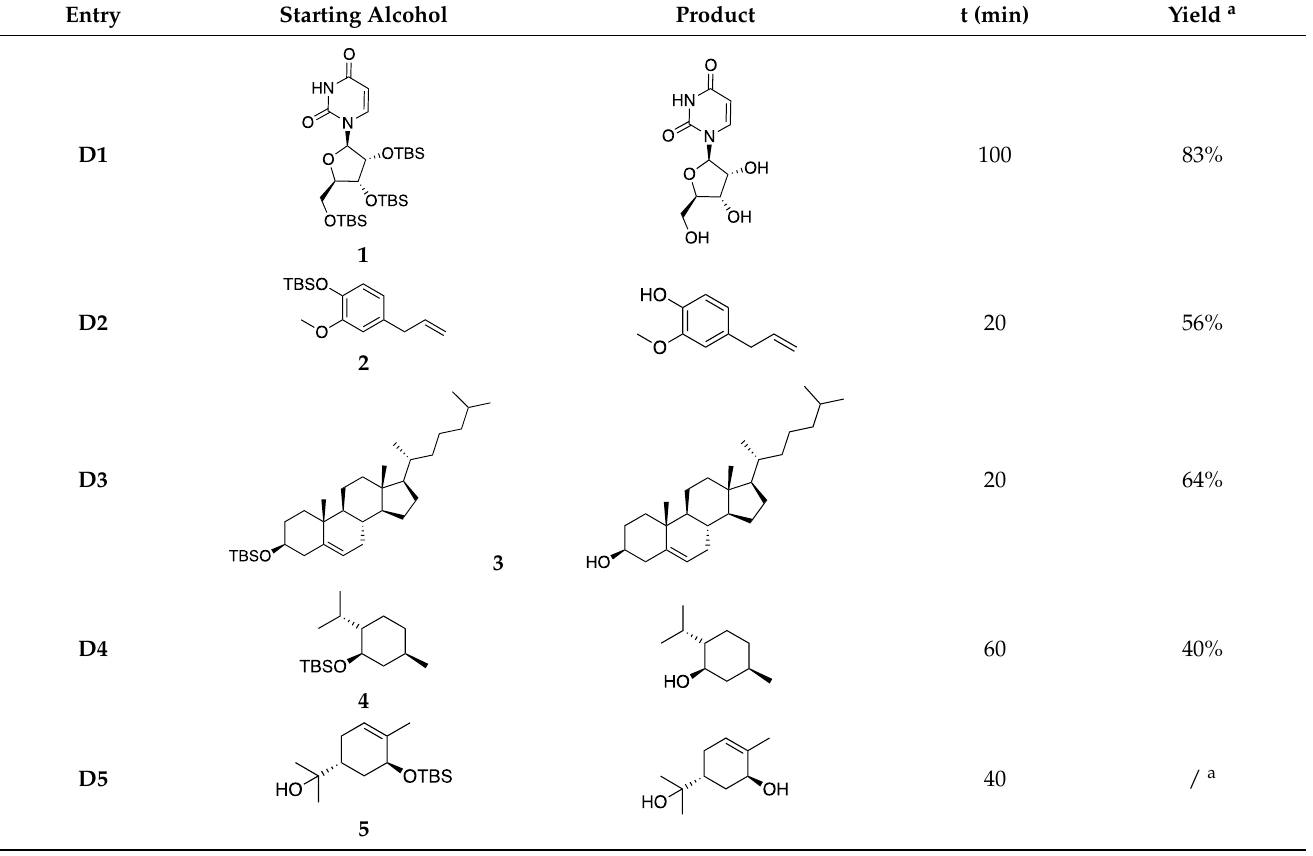
Table 3. Deprotection of the previously obtained silyl ethers 1 – 5 (Table 2) using the DowexWX4- 200/MeOH reagent system.